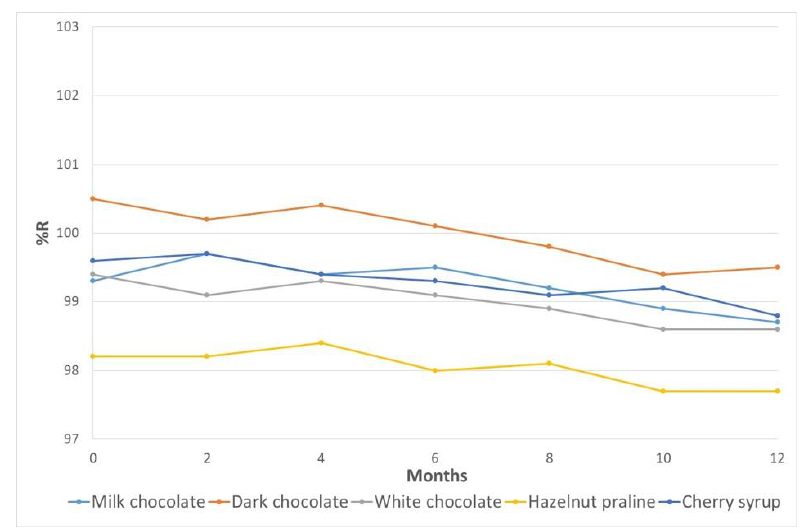
Figure 11. Stability test for the new formulations over a period of 12 months.